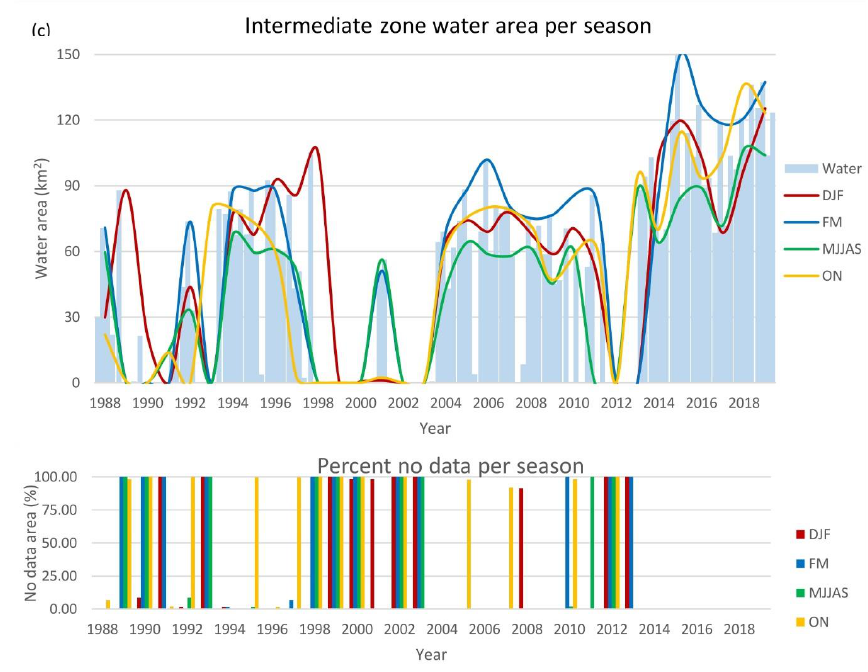
Figure 9. Surface water area per season per year with no data per season per year for ( a ) Dry, ( b ) Wet, and ( c ) Intermediate zones.